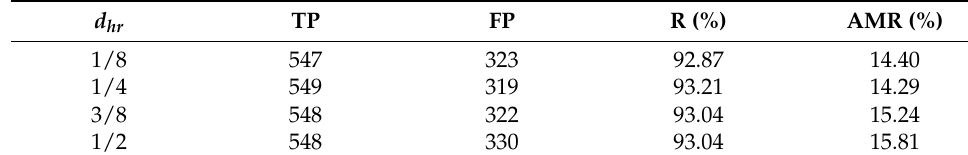
Table 6. Comparison of different d hr values in the integrated detector.